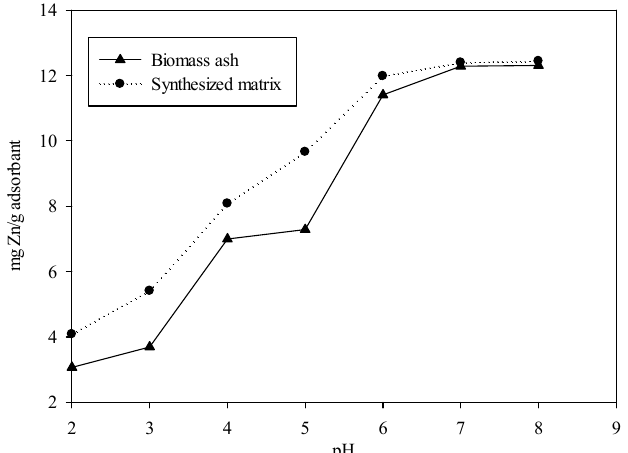
Figure 1. Effect of pH on the adsorption of Zn 2+ on biomass ash and modified biomass ash (initial concentration of Zn 2+ , 50 mg/L; biomass ash concentration, 4 g/L; T = 30 °C).